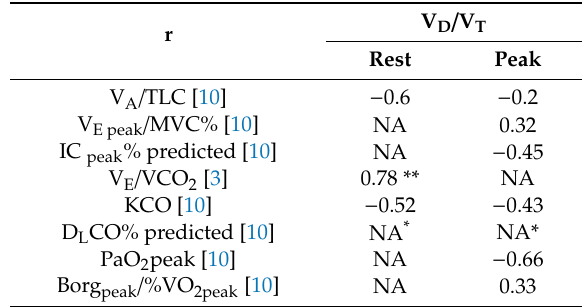
V A , alveolar volume measured during di ff using capacity for carbon monoxide (DLCO) measurement; TLC, total lung capacity; IC, inspiratory capacity; V E , minute ventilation; CO 2 , CO 2 output; KCO, the di ff using constant of Krogh, i.e., D L CO / V A without considering barometric pressure, where V A is alveolar volume in BTPS equal to TLC measured by single breath helium dilution method after subtracting anatomic dead space [34]; Borg, Borg score.